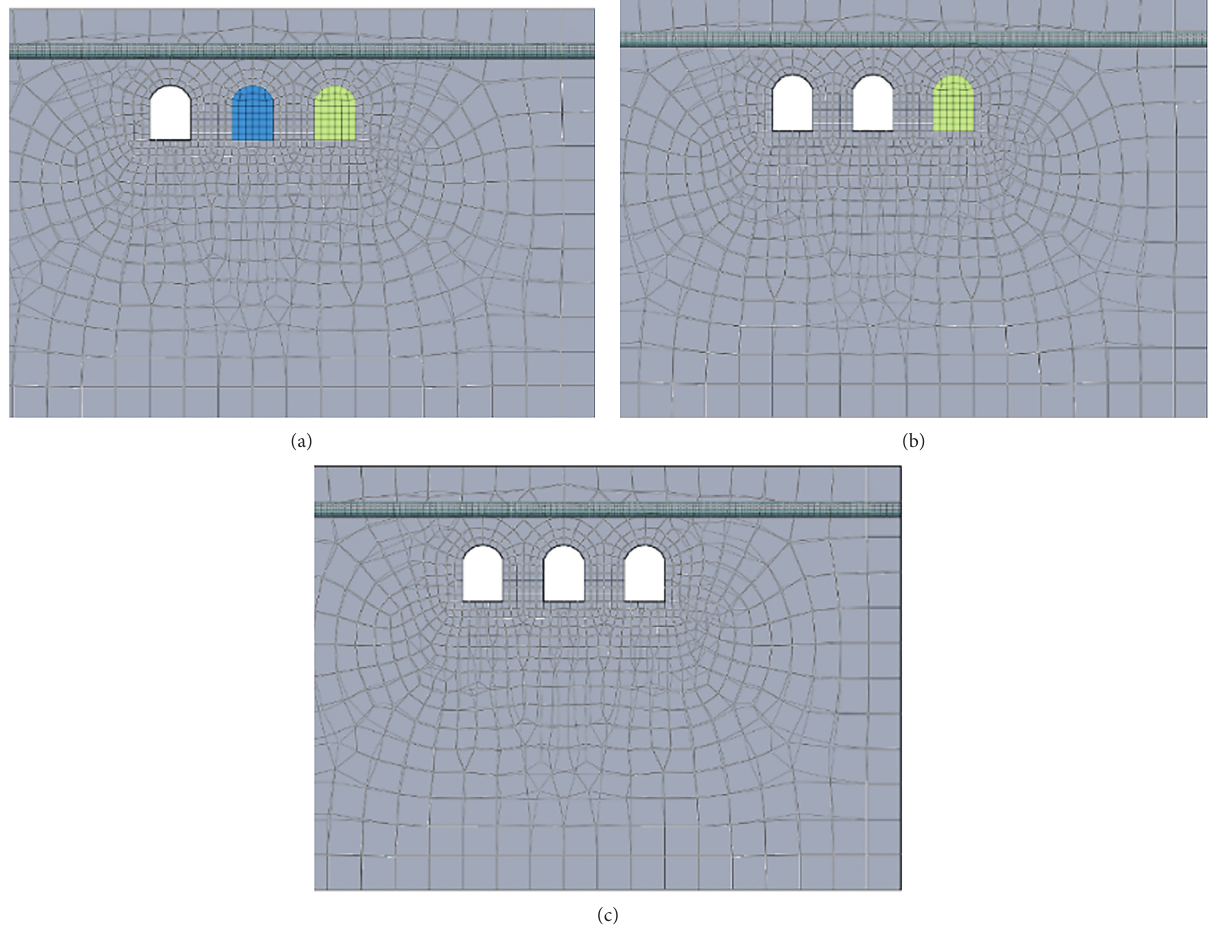
Figure 4: Excavation steps: (a) step 1: excavate section A, (b) step 2:excavate section B, and (c) step 3: excavate section C.